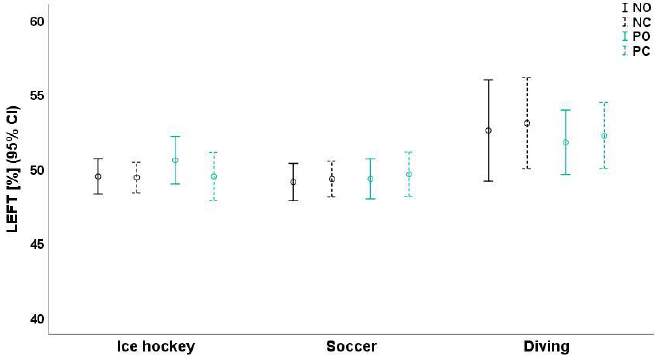
Figure 3. Medio-lateral load distribution (LEFT%) between sports during four test conditions (NO, NC, PO, PC). Values are provided as mean and 95% CI.